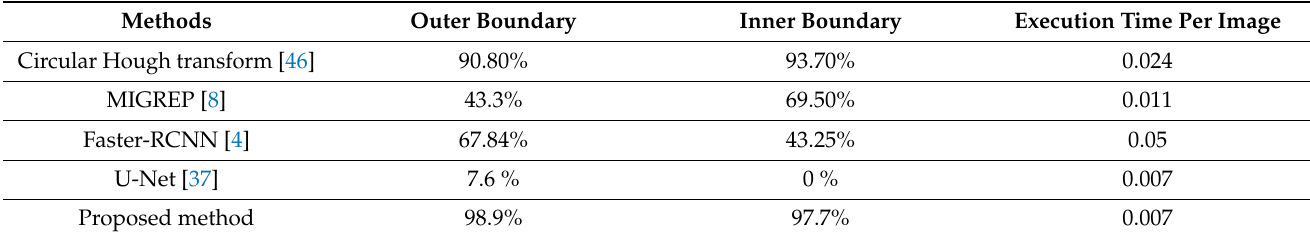
Table 1. Comparison of segmentation accuracy with other works (intersection over union (IOU) threshold is defined as 0.8).